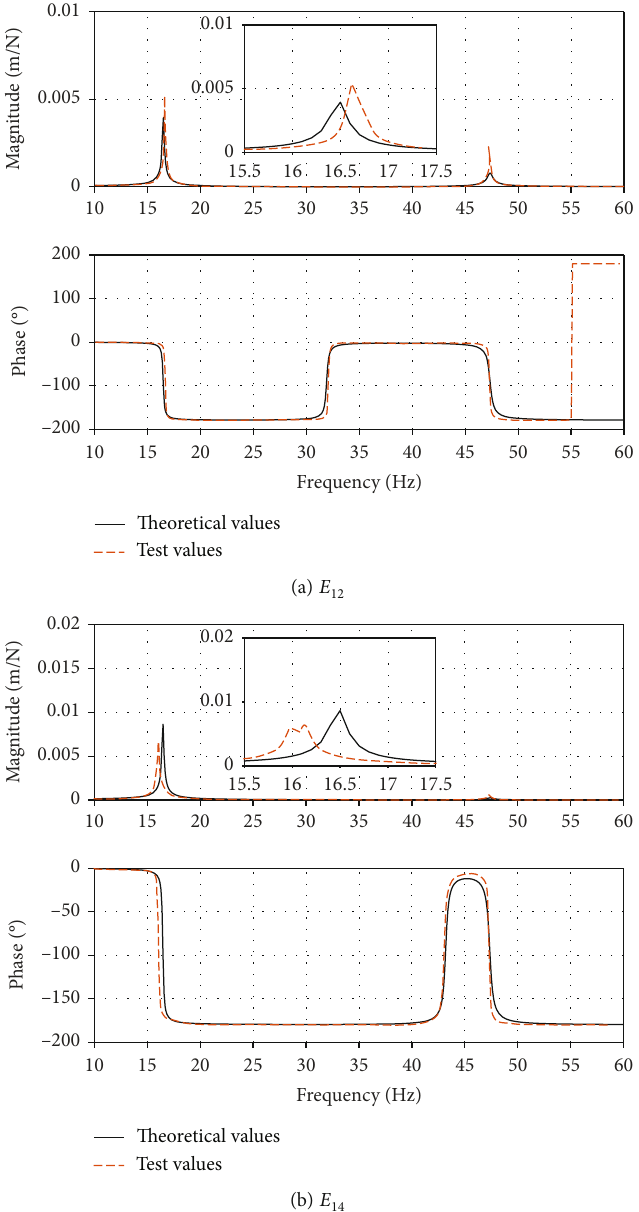
Figure 12: Comparison of structural